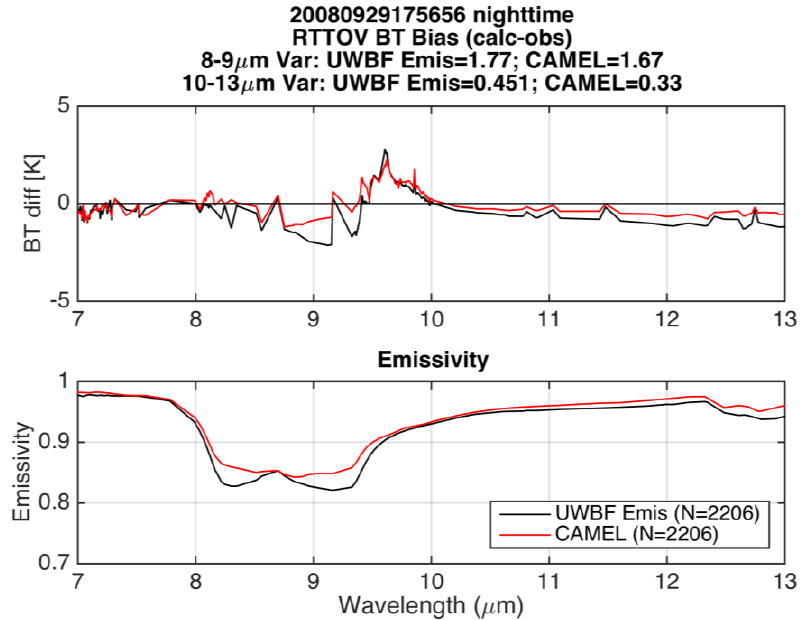
Figure 12. IASI observed brightness temperatures are compared to those calculated using the Radiative Transfer for TOVS (RTTOV) UW IR emissivity module based on the UW BF emissivity database (black) and the CAMEL emissivity database (red) for the granule at 17:56 UTC, on 29 September 2008. The debiased variances are included over the 8–9 μm and 10–13 μm spectral regions.